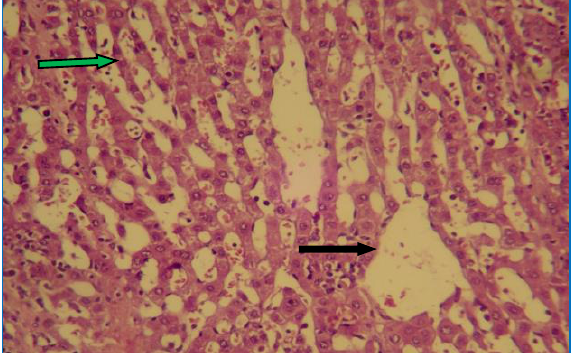
Figure, 4: G2: Liver of rabbit at 20 days post infection show telangiectasis ( ) with marked atrophy of hepatocytes ( ) (H and E 40